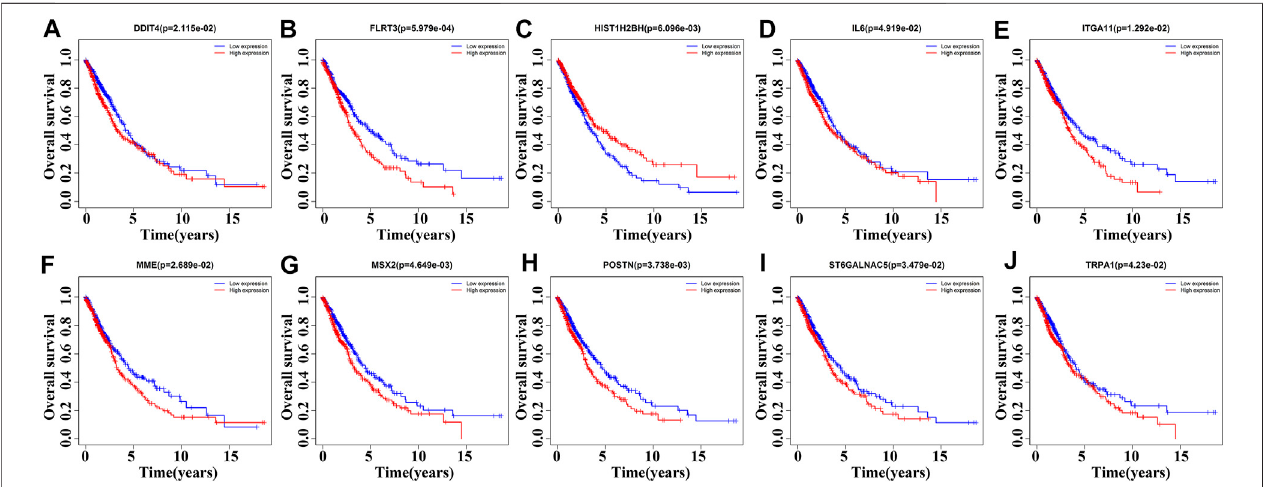
FIGURE 3 | Roles of DEGs of MSCs in the overall survival of NSCLC patients determined via survival analysis. (A) DDIT4 ; (B) FLRT3 ; (C) HIST1H2BH ; (D) IL6 ; (E) ITGA11 ; (F) MME ; (G) MSX2 ; (H) POSTN ; (I) ST6GALNAC5 ; (J) TRPA1 .MSCs,Mesenchymalstemcells; DEGs,differentiallyexpressed genes;NSCLC, Non-small-cell lung